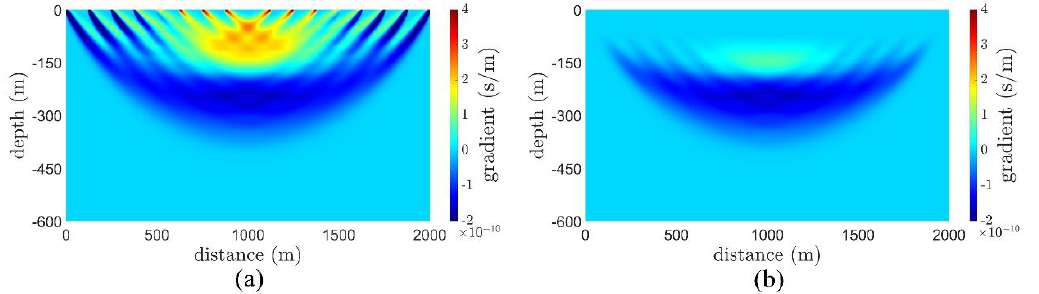
Figure 4. Regularization of TDAT. Gradient of multiple source − receiver pairs obtained by TDAT: ( a ) without regularization and ( b ) with regularization.